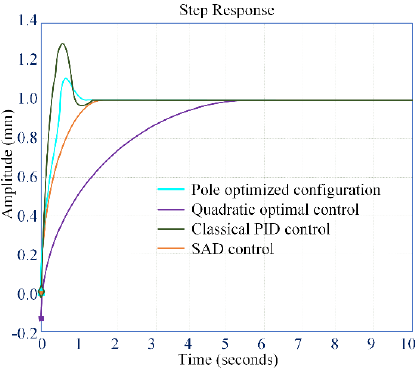
Figure 10. Step response curve of unit step signal under four control strategies.